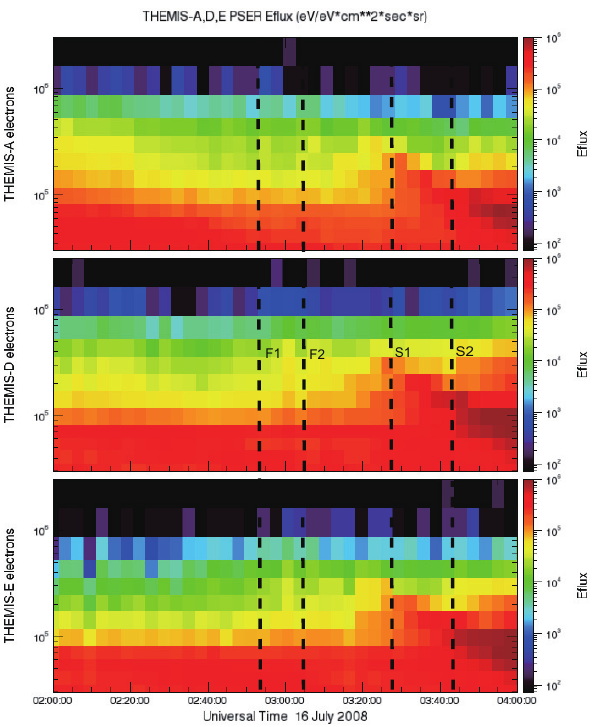
Fig. 11. In the same format as Fig. 10, except for energetic ion